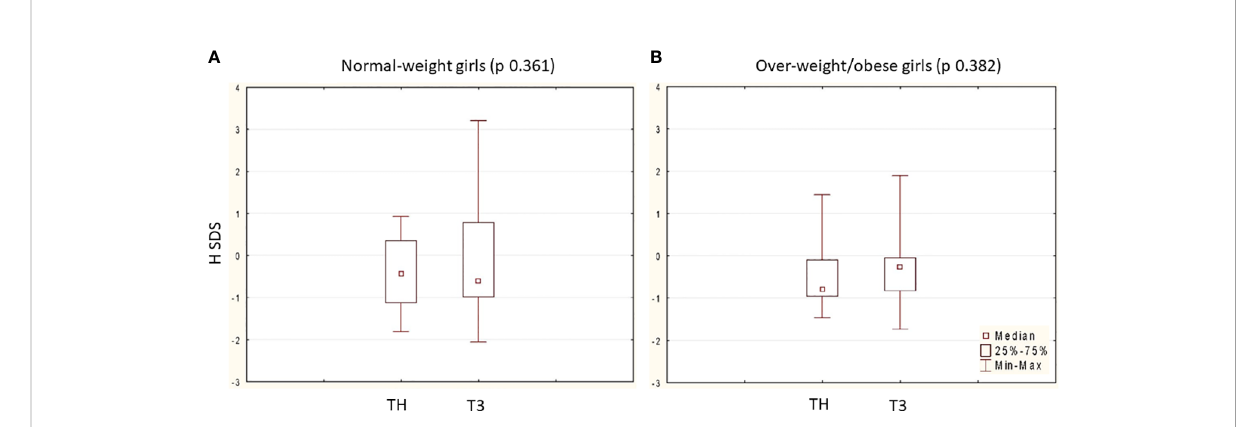
FIGURE 1 Comparison between nFH/FH SDS (T3) and TH SDS in the two group: (A) 33 normal-weight girls (TH SDS vs. nFH/FH SDS p 0.361) and (B) 24 over-weight/obese girls (TH SDS vs. nFH/FH SDS p 0.382). Data are expressed as median, 25 ˚ and 75 ˚ percentile and range (min-max). In each group, p is calculated at Wilcoxon matched pairs test.